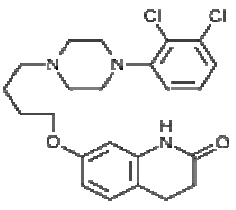
Figure 1. The structure of